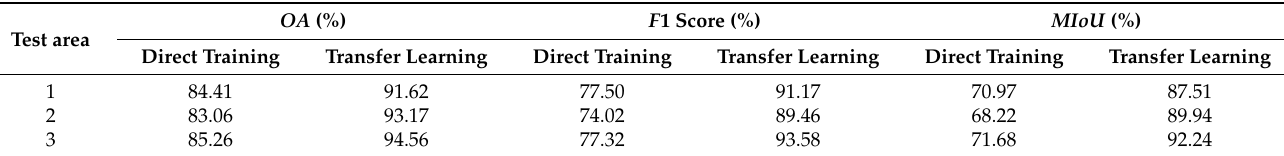
Table 6. Precision evaluation